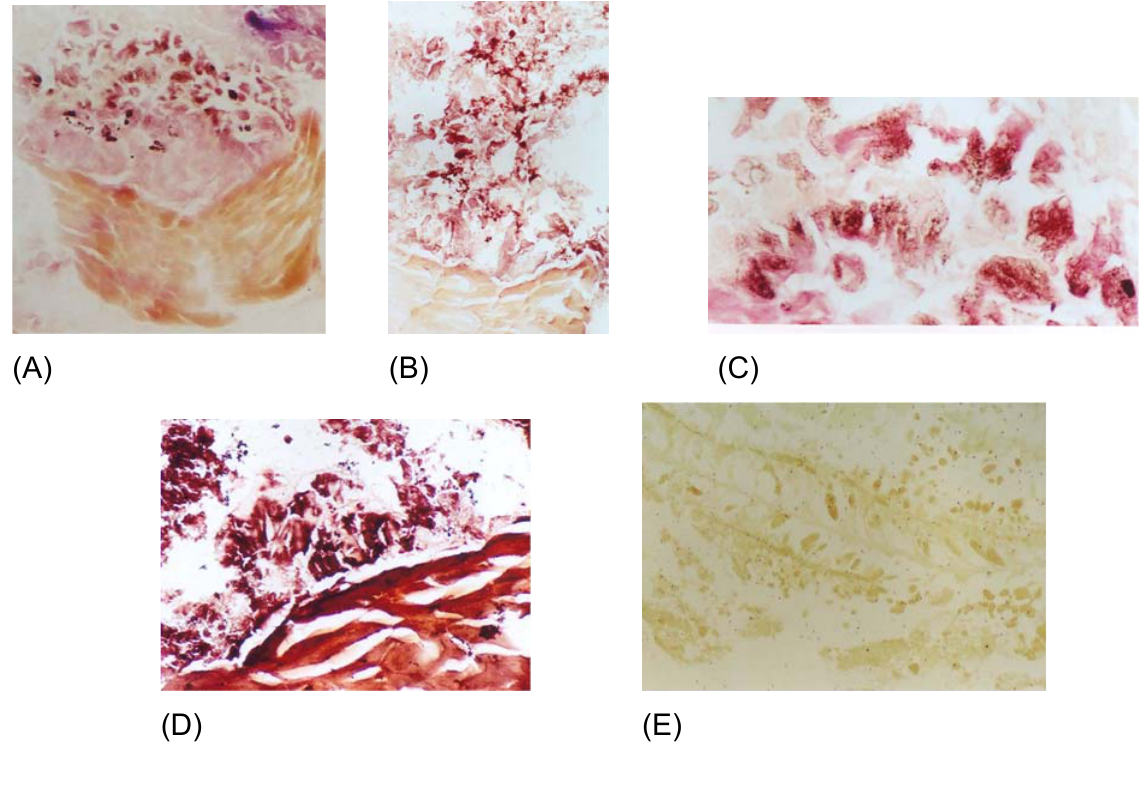
Figure 3. Cross-section of A. crassicauda venom glands